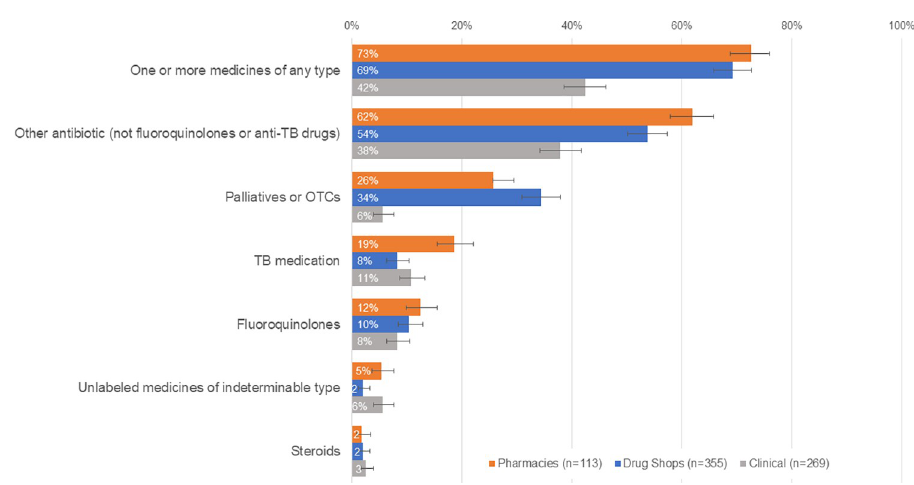
Fig 2. Case 1: Medicines dispensed to SPs presenting as presumptive patients, by facility type.